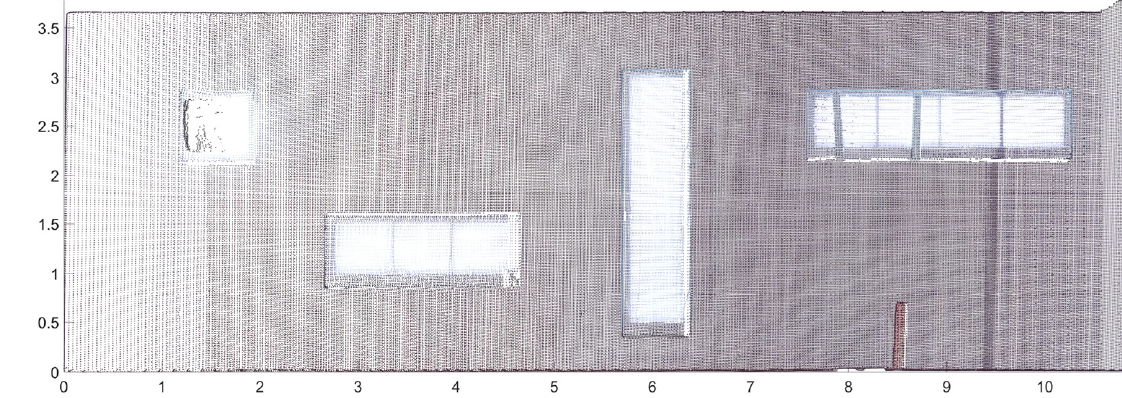
Figure 9. Result of laser scanning, point cloud—wall no. 3.